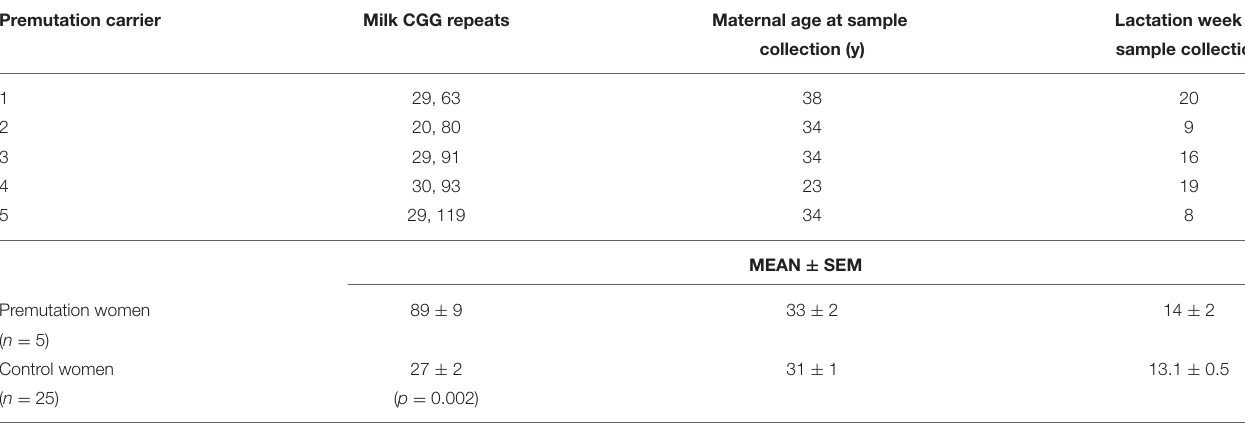
TABLE 5 | Details of the study